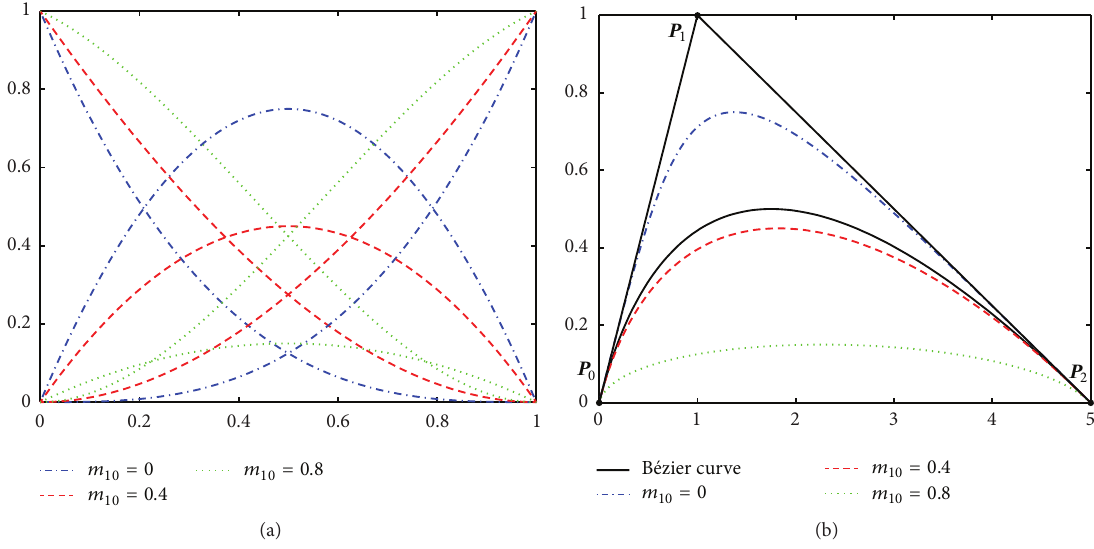
Figure 1: Quasi-Bernstein basis functions and Quasi-B´ezier curves when 𝑛 1 = 2 and 𝑛 2 = 3